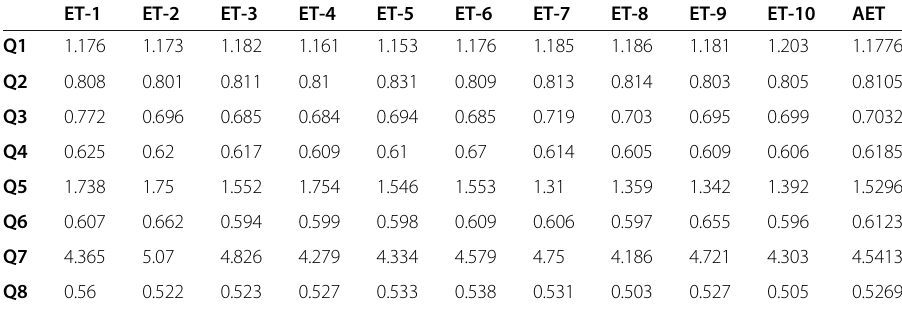
Table 6 Query execution time for Amazon EC2 with Colorado State data in HC-2